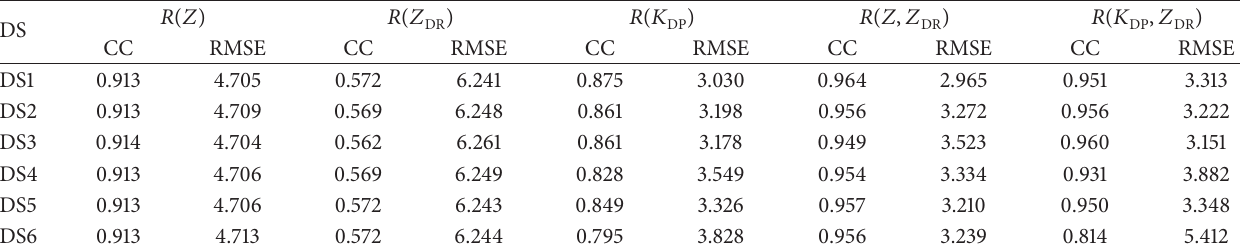
Table 3: The correlation coefficients and RMSEs (mm) of rainfall obtained by rainfall relations and DSDs. CC means cross correlation. 𝑅(𝑍) DS